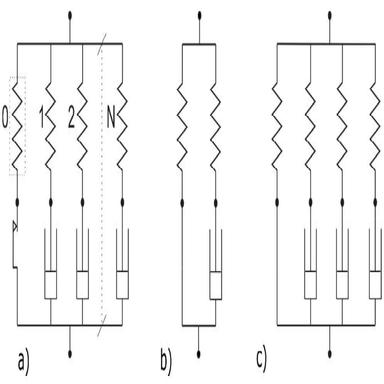
a) general scheme of PRF; (b) scheme of BB viscoelastic model; (c) scheme of PRF (combination of Yeoh model and Power law)